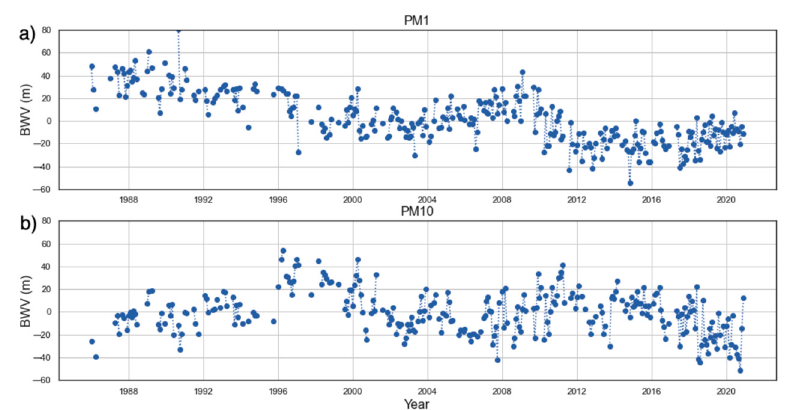
Figure 6. Monthly BWV series at ( a ) PM1 and ( b ) PM10 transects.